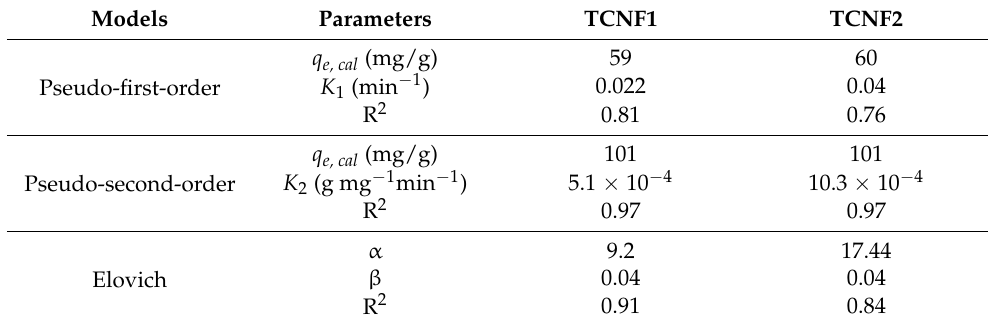
Table 1. Kinetic parameters for MB adsorption for TOCNF1 and TOCNF2.